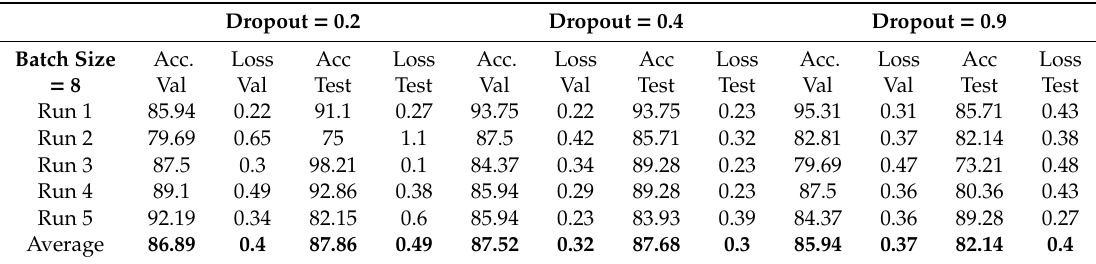
Table 5. CNN model (epochs = 200, pixel = 256 × 256, conv (8- > 16- > 32), dense = 64) runs for di ff erent dropouts.